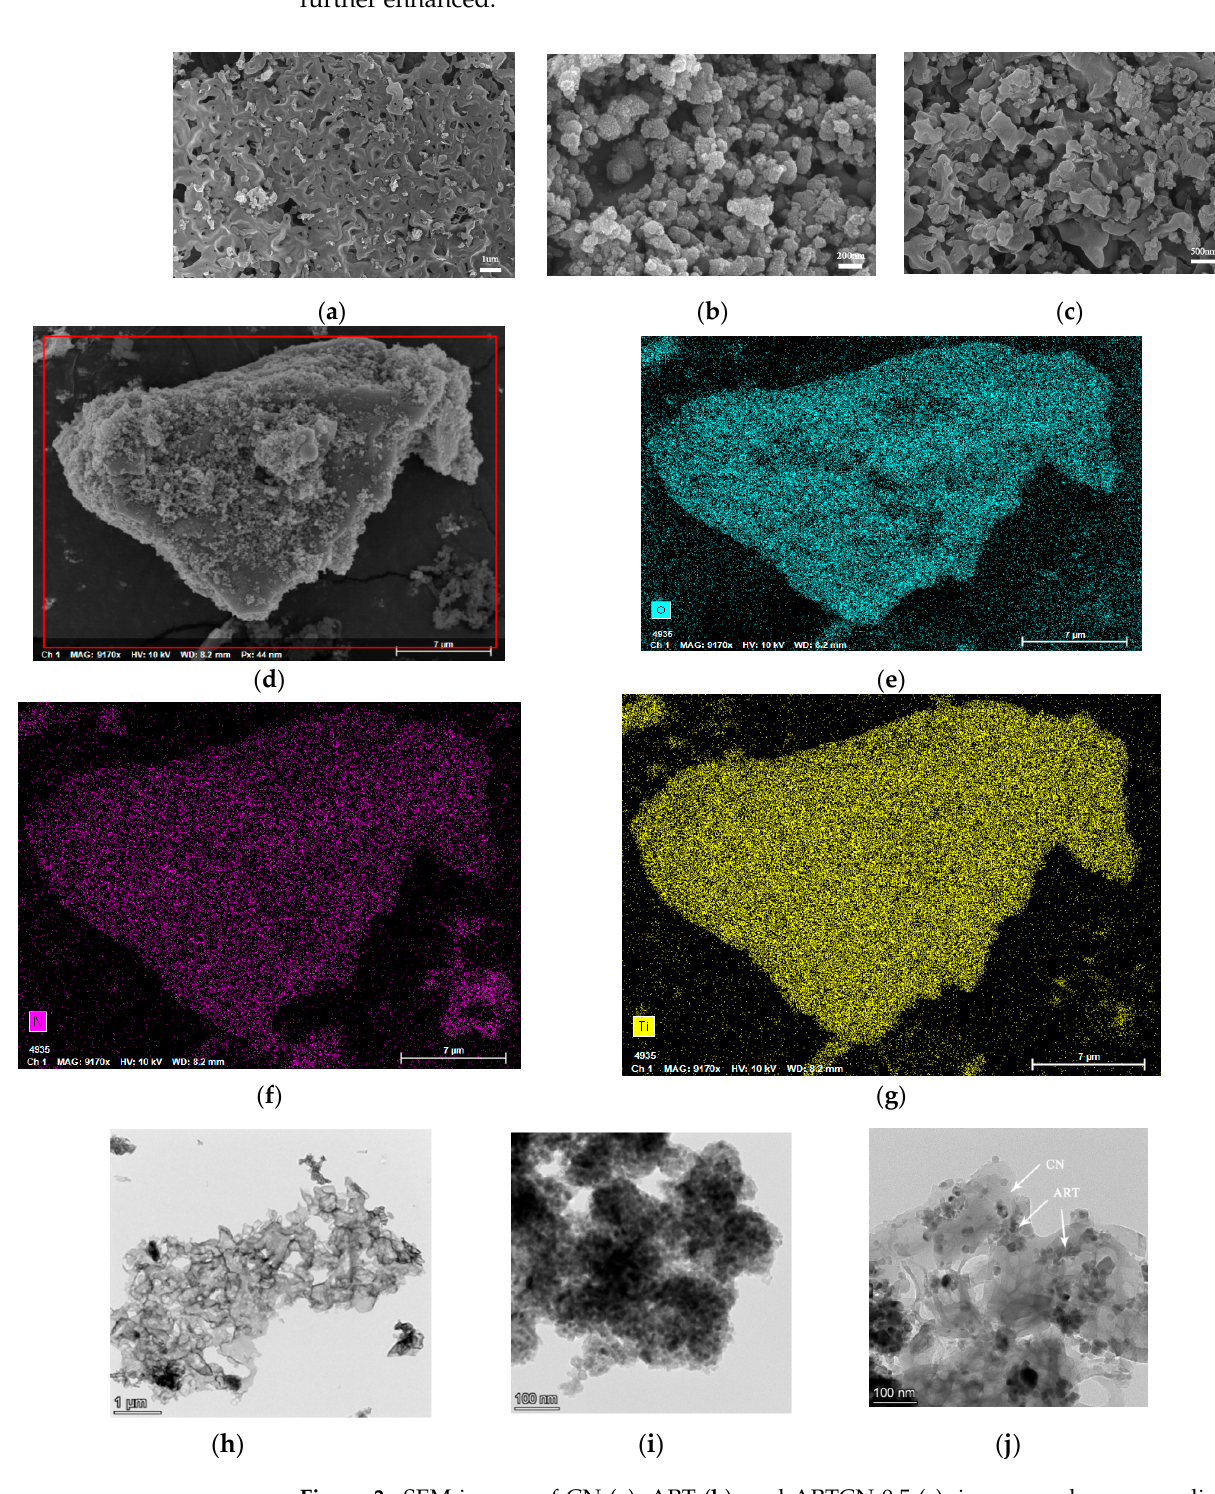
Figure 3. SEM images of CN ( a ), ART ( b ), and ARTCN-0.5 ( c ); images and corresponding EDS elemental mapping images ( d – g ) of the ARTCN-0.5, TEM of CN ( h ), ART ( i ), and ARTCN-0.5 ( j ).